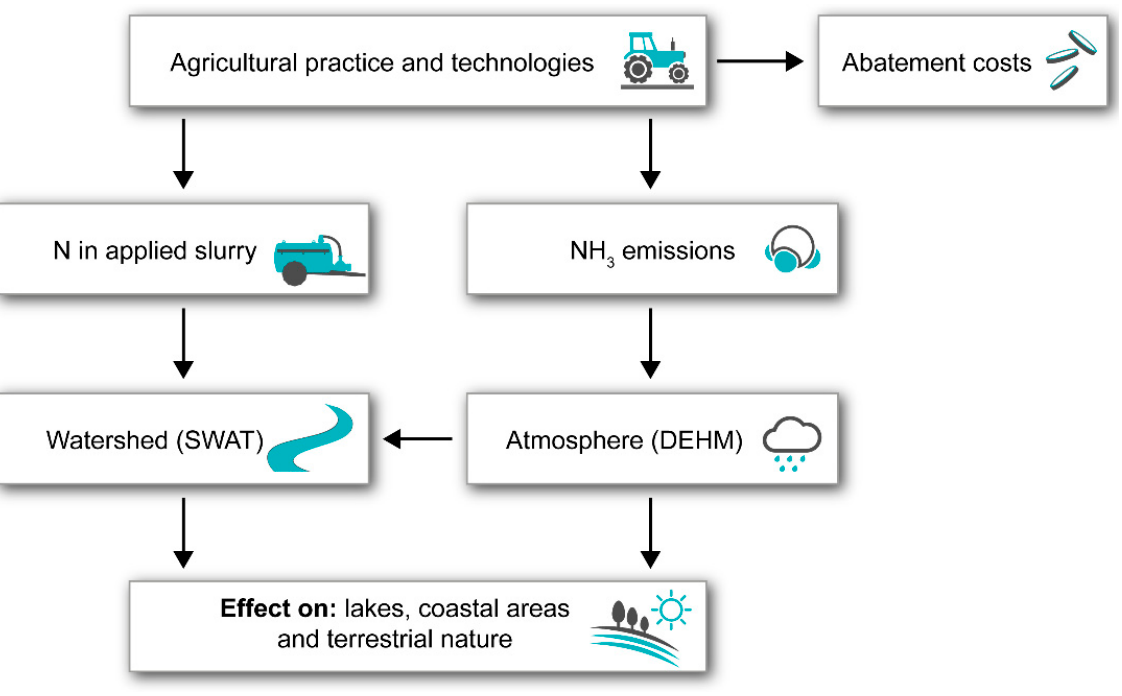
Figure 1. A schematic overview of the DEEMON model system linking the main compartments of the environment. The atmosphere compartment is described by the DEHM model; the watershed is described by the SWAT model, while the aquatic areas are described by the GOTM-FABM-PCLake and PLS models. Quantification of exceedances of critical loads were used to study the effects on terrestrial nature, and the economic consequences of solutions are estimated as changes in abatement costs for Nr reductions into air and the aquatic environment.